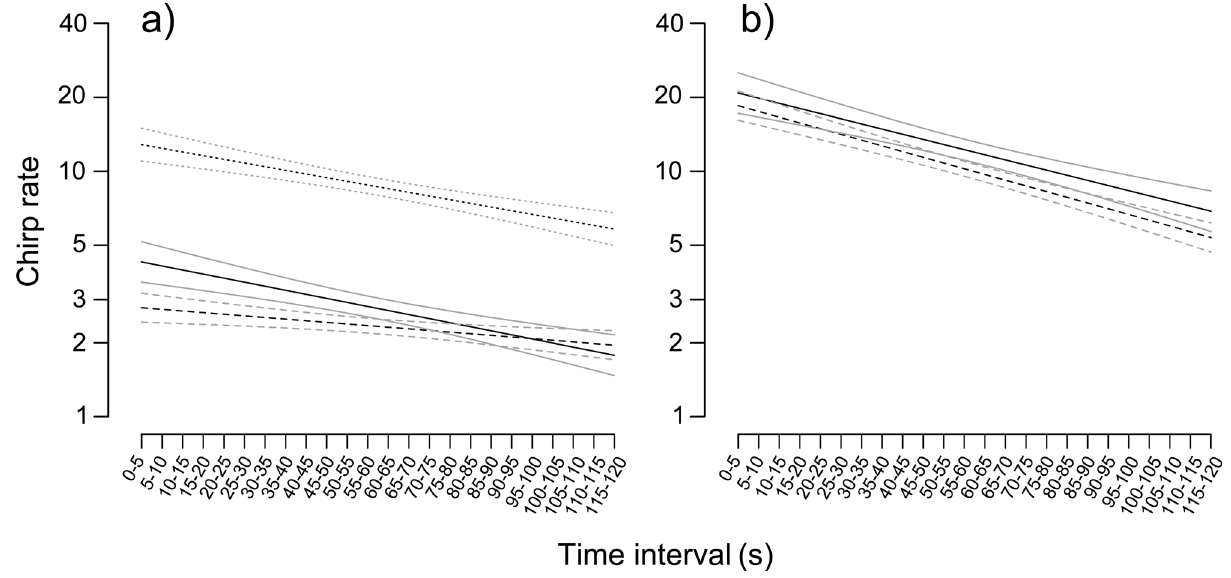
Figure 5. Temporal dependence of the number of chirps produced for each of the 24 five-second consecutive intervals ( chirp repetition ) for both Test 1 ( a ) and Test 2 ( b ), with their models fitted (black lines) and the standard errors of predicted values (grey lines). Test 1 ( a ): dashed lines, queens; solid lines, males; dotted lines, workers. Test 2 ( b ): solid lines, small honey drops; dashed lines, large honey